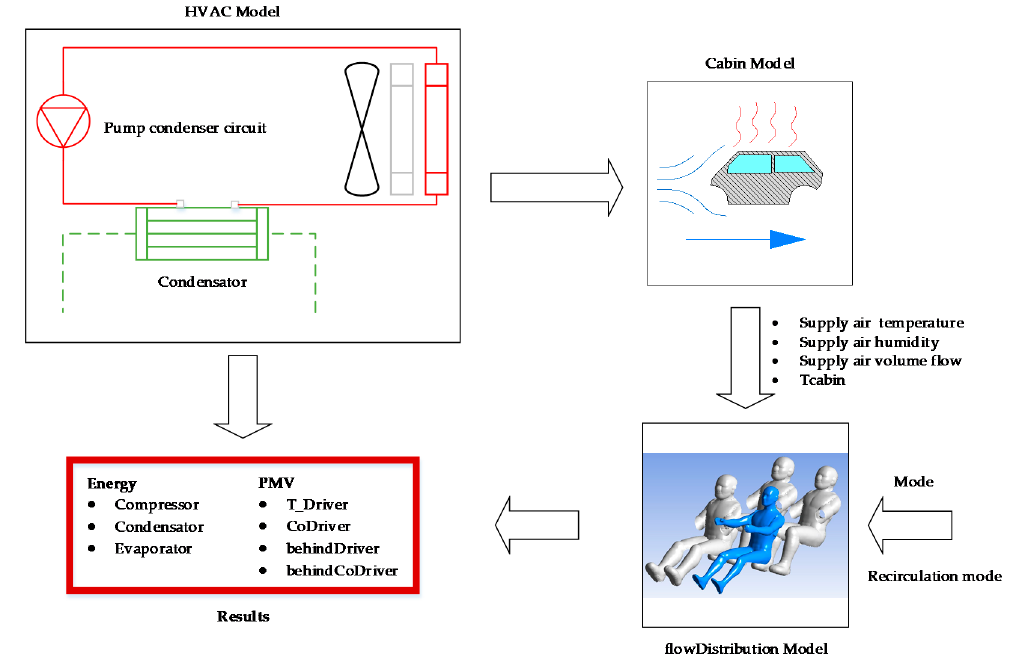
Figure 8. Scheme integration CFD simulation in 1D.